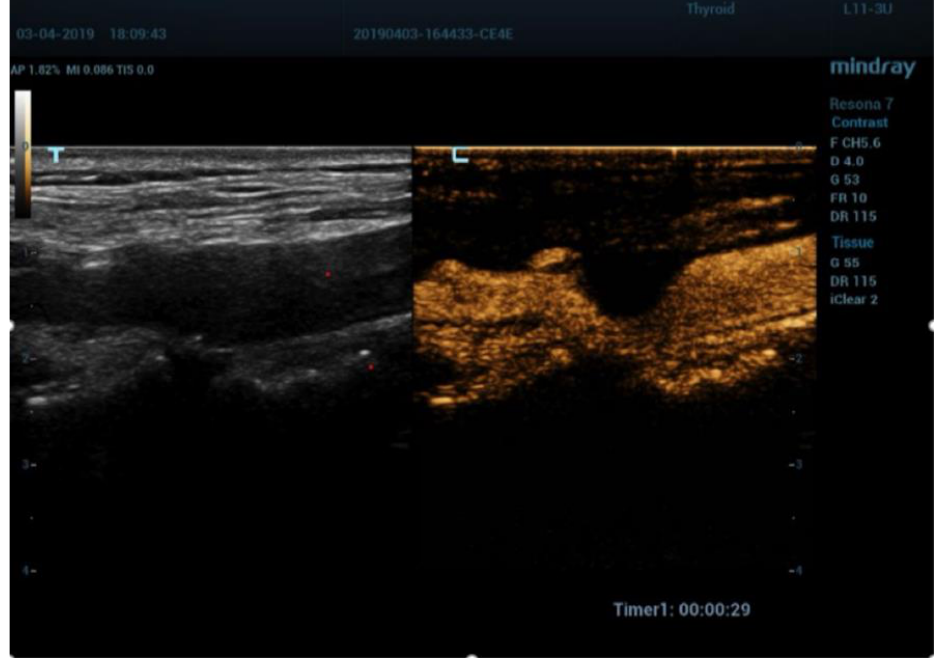
Figure 5. CEUS of carotid stenosis at 29 s arterial phase. Same patient as Figure